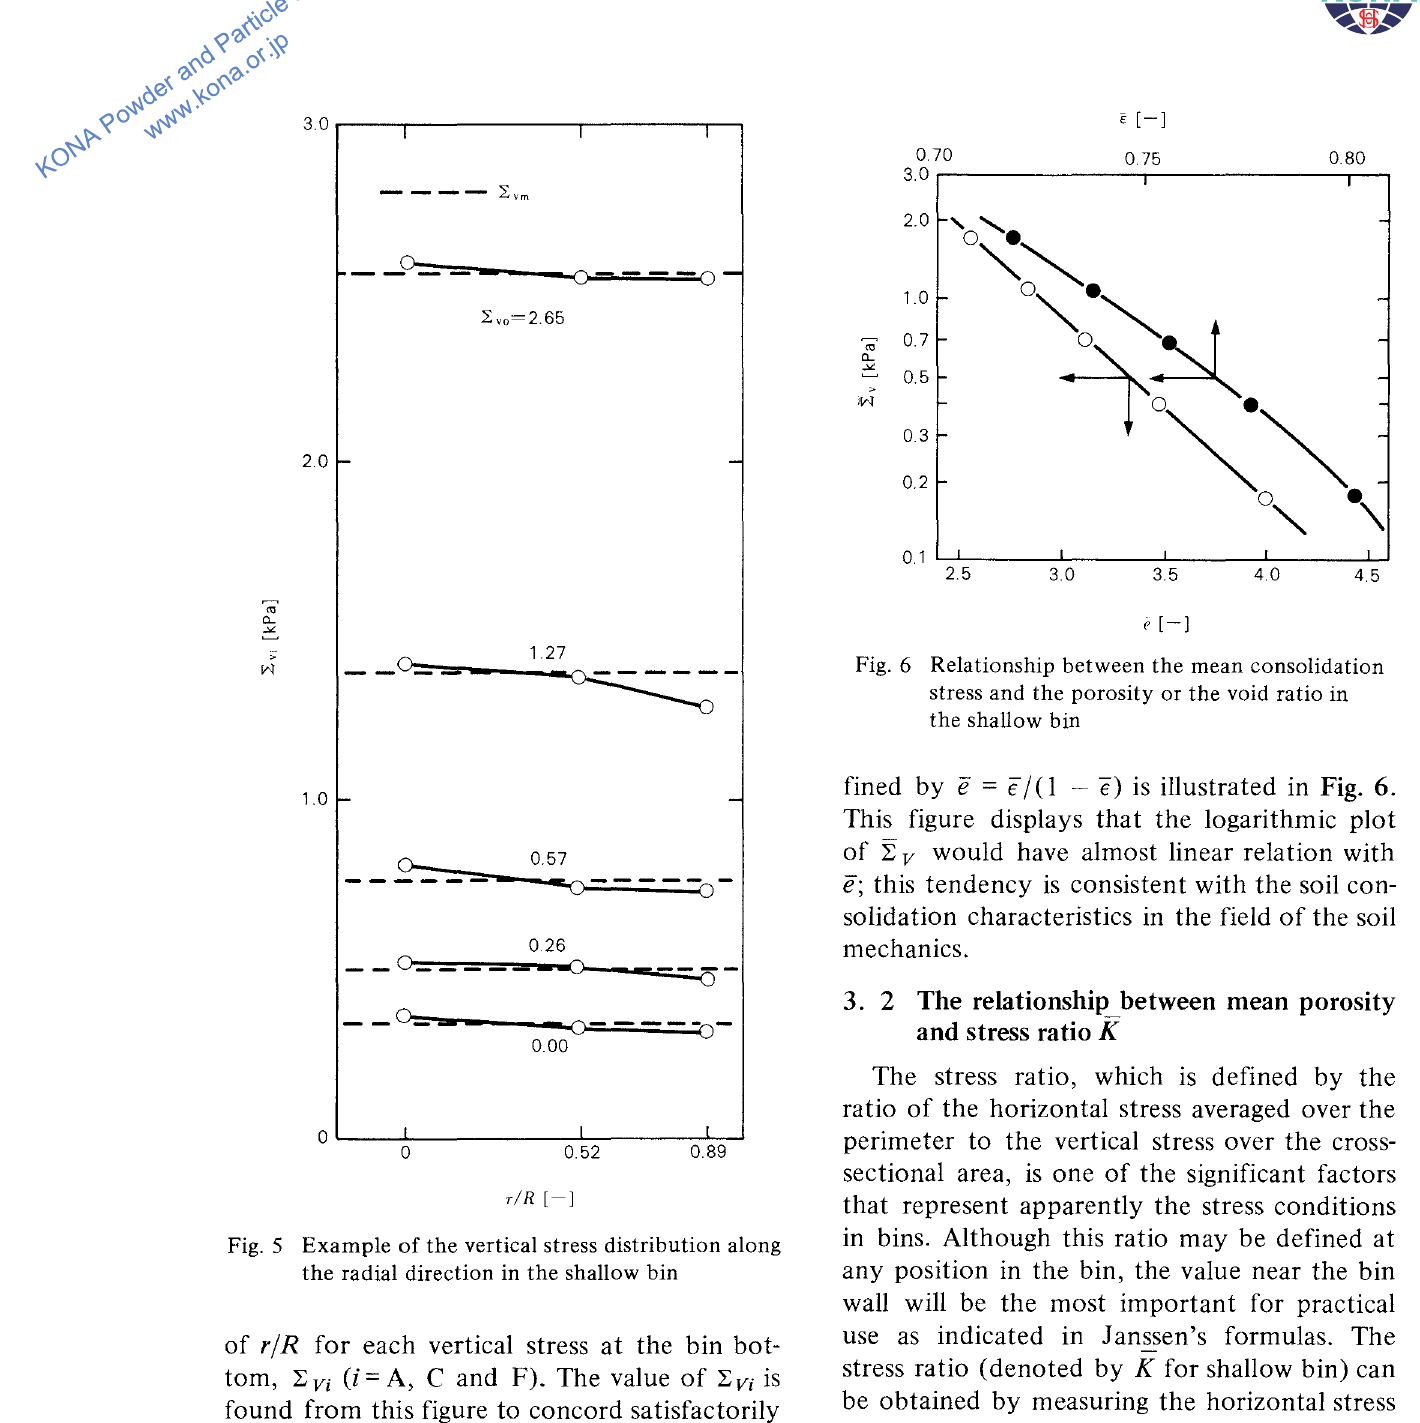
Fig. 5 Example of the vertical stress distribution along the radial direction in the shallow bin of r/R for each vertical stress at the bin bot tom, ~Vi (i =A, C and F). The value of ~Vi is found from this figure to concord satisfactorily with the mean vertical stress, which is denoted as the whole weight exerted on the bin bottom devided by the cross section area of the bin, ~ vm, for a given value of ~ vo measured in the present experiment. This result suggests that the pressure transducers used would be com monly applicable to determination of powder stresses.